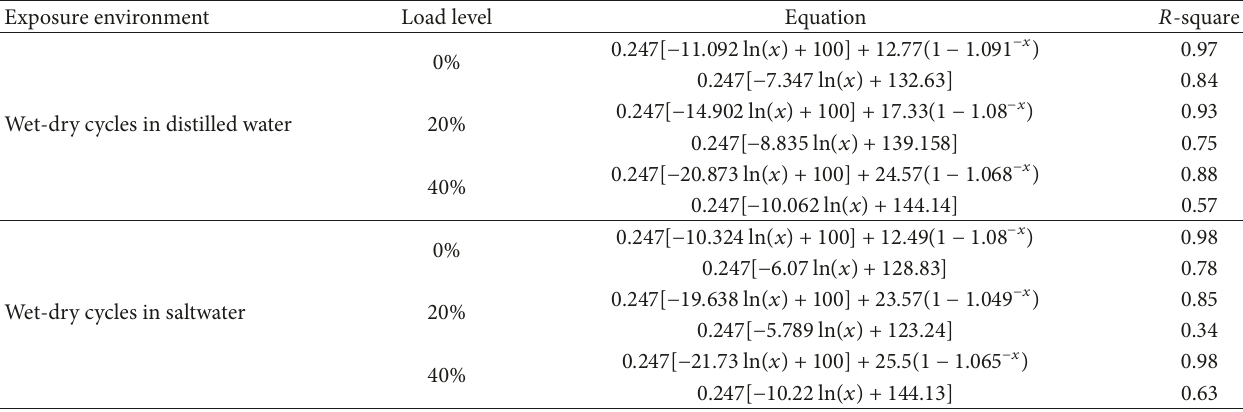
Table 4: Predictive equations for elastic